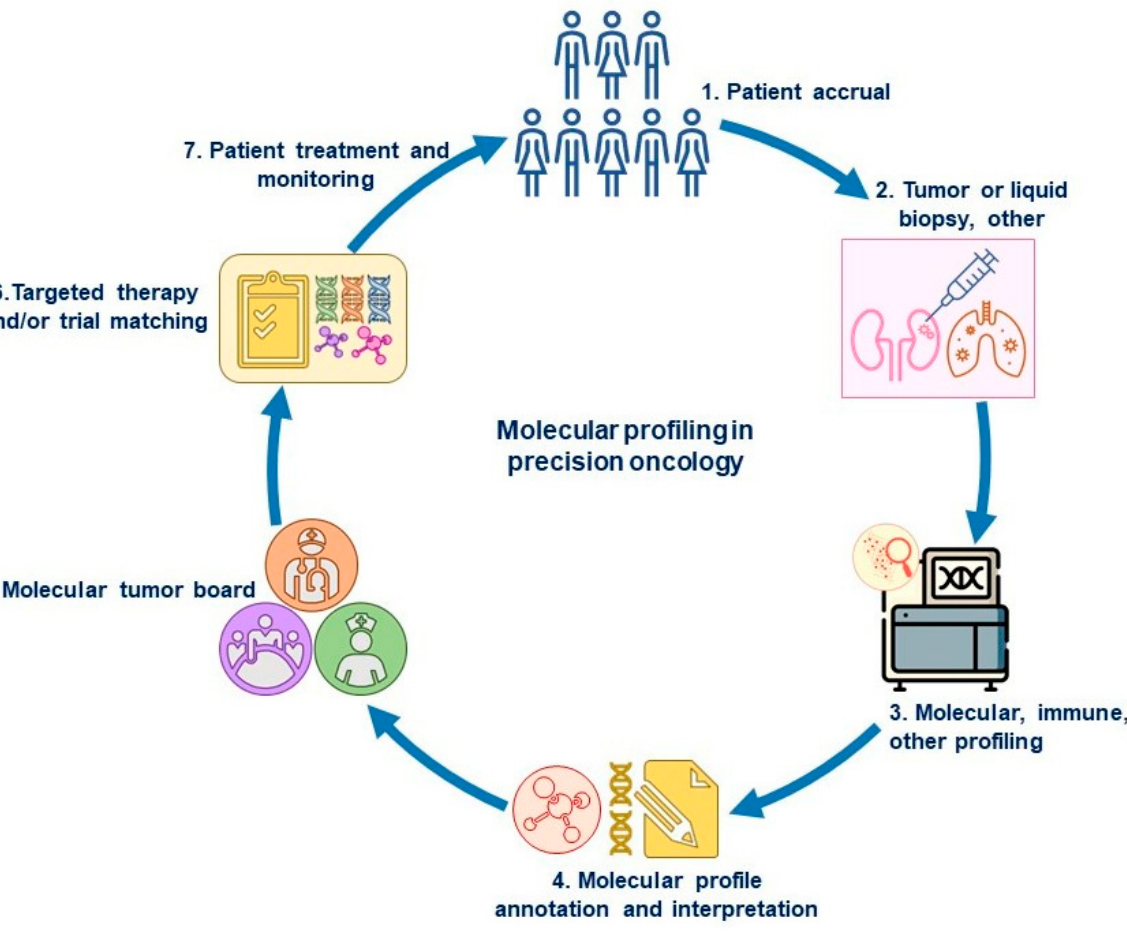
Figure 1. Overview of molecular profiling in precision oncology. In the screening phase of a biomarker-driven trial, patients (1) undergo a tumor biopsy or blood draw (liquid biopsy) (2) that is used for tumor molecular profiling (3) to determine the drivers of carcinogenesis (genomic or protein level), if any (4). The molecular profile report is often discussed at a molecular tumor board (5) for the interpretation of tumor alterations and for matching with a targeted therapy or clinical trial (6). The patient is then treated with the assigned therapy (FDA-approved or investigational drug after screening for clinical trial) and monitored for anti-tumor effects and toxicity (7). If the disease progresses, the next treatment can again be selected from a new round of tumor or blood analyses to identify evolving biomarkers.